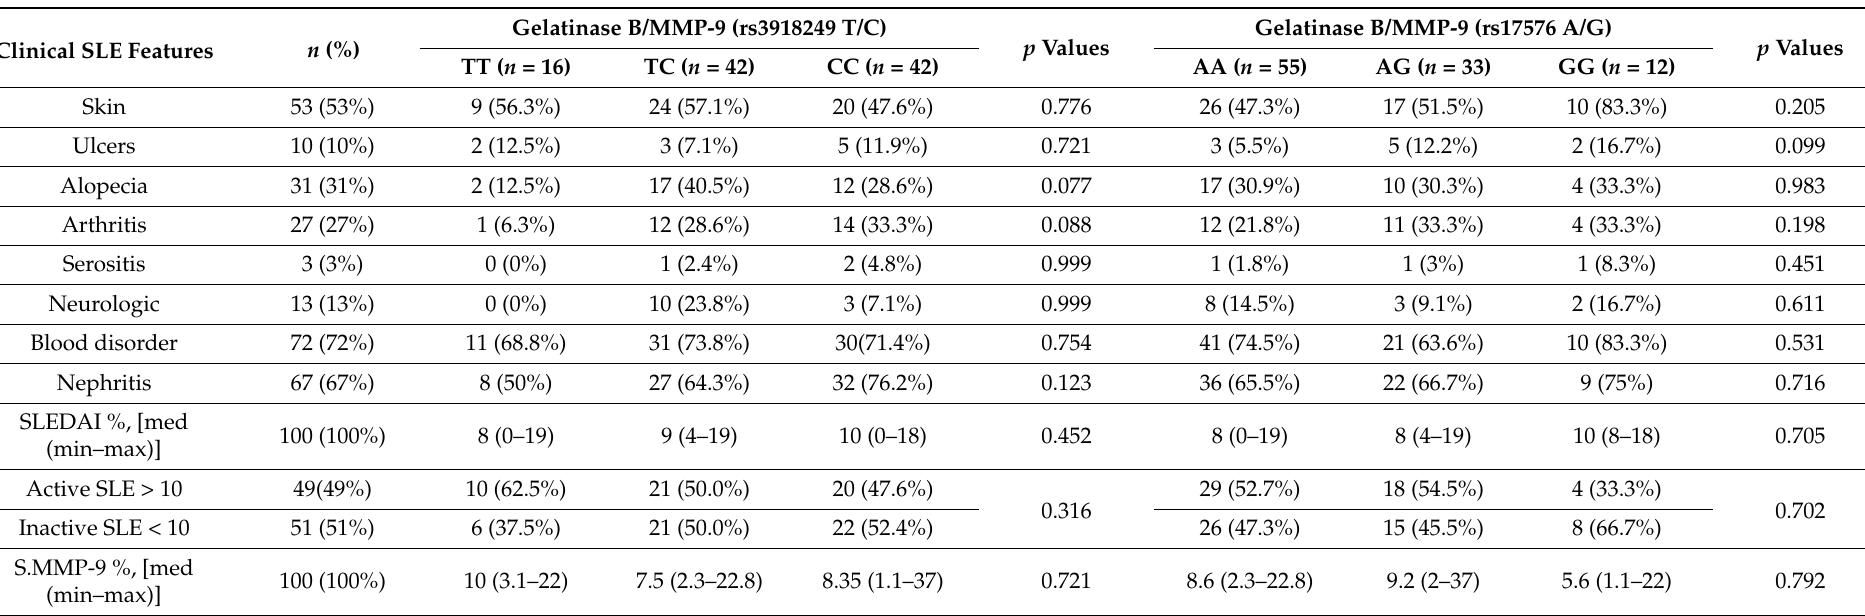
Table 5. Gelatinase B/MMP-9 genotypes (rs3918249 T/C and rs17576 A/G) regression analysis for the prediction of clinical characteristics of systemic lupus erythematosus